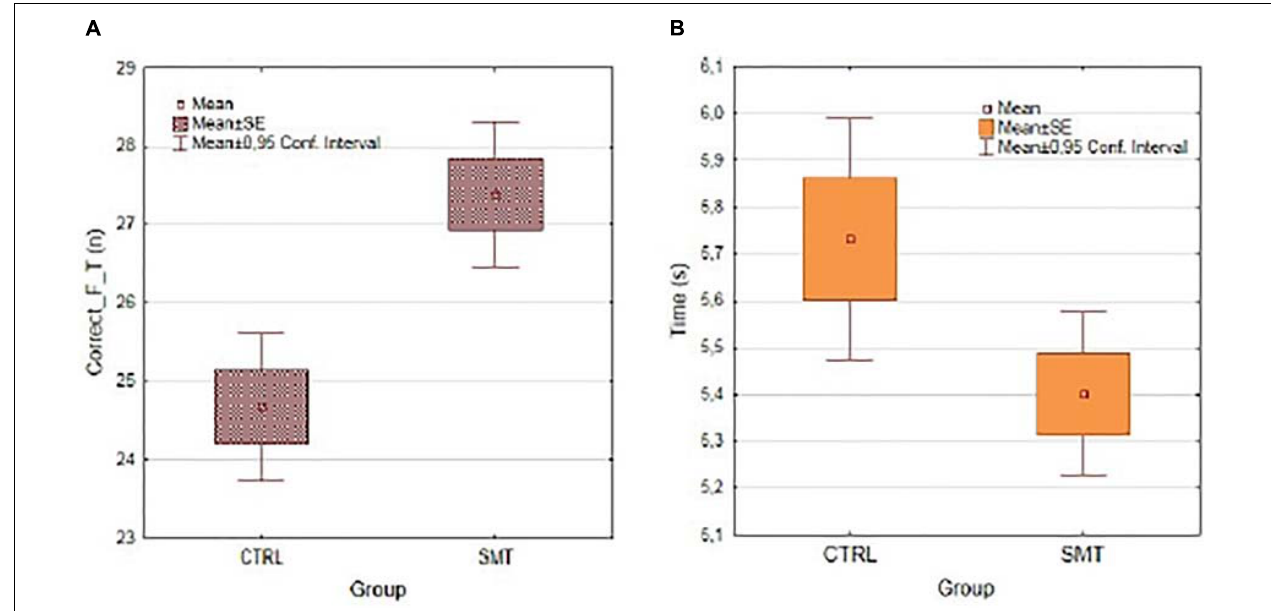
FIGURE 3 | Presenting (A) the mean number of correct foot taps during the 20 s stepping task as a function of groups at the post-test comparison, and (B) the mean duration to complete the first six steps of the stepping task as a function of group at the post-test comparison.